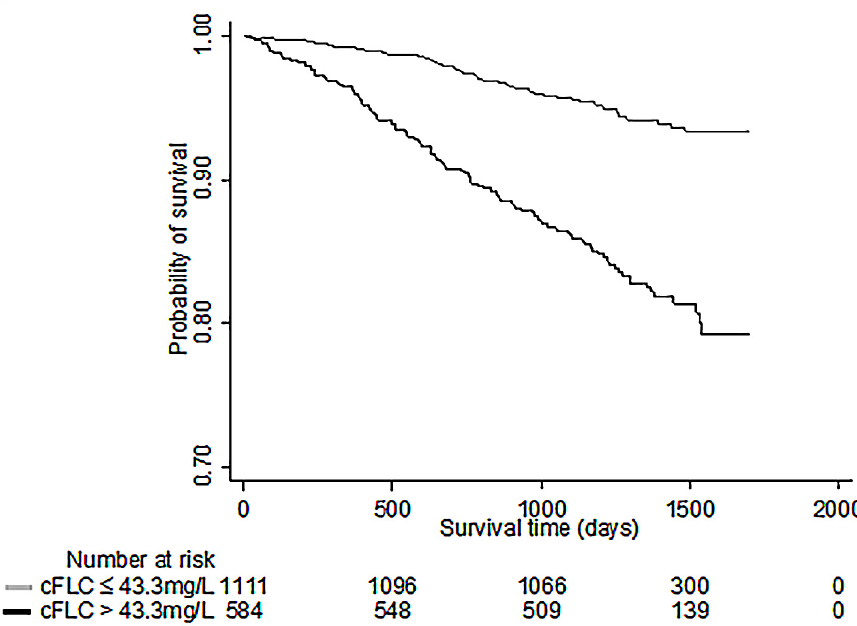
significantly longer overall survival compared to participants with cFLC > 43.3 mg/L. Log rank analysis: P < 0.001. Note that the x axis does not intersect the y axis at